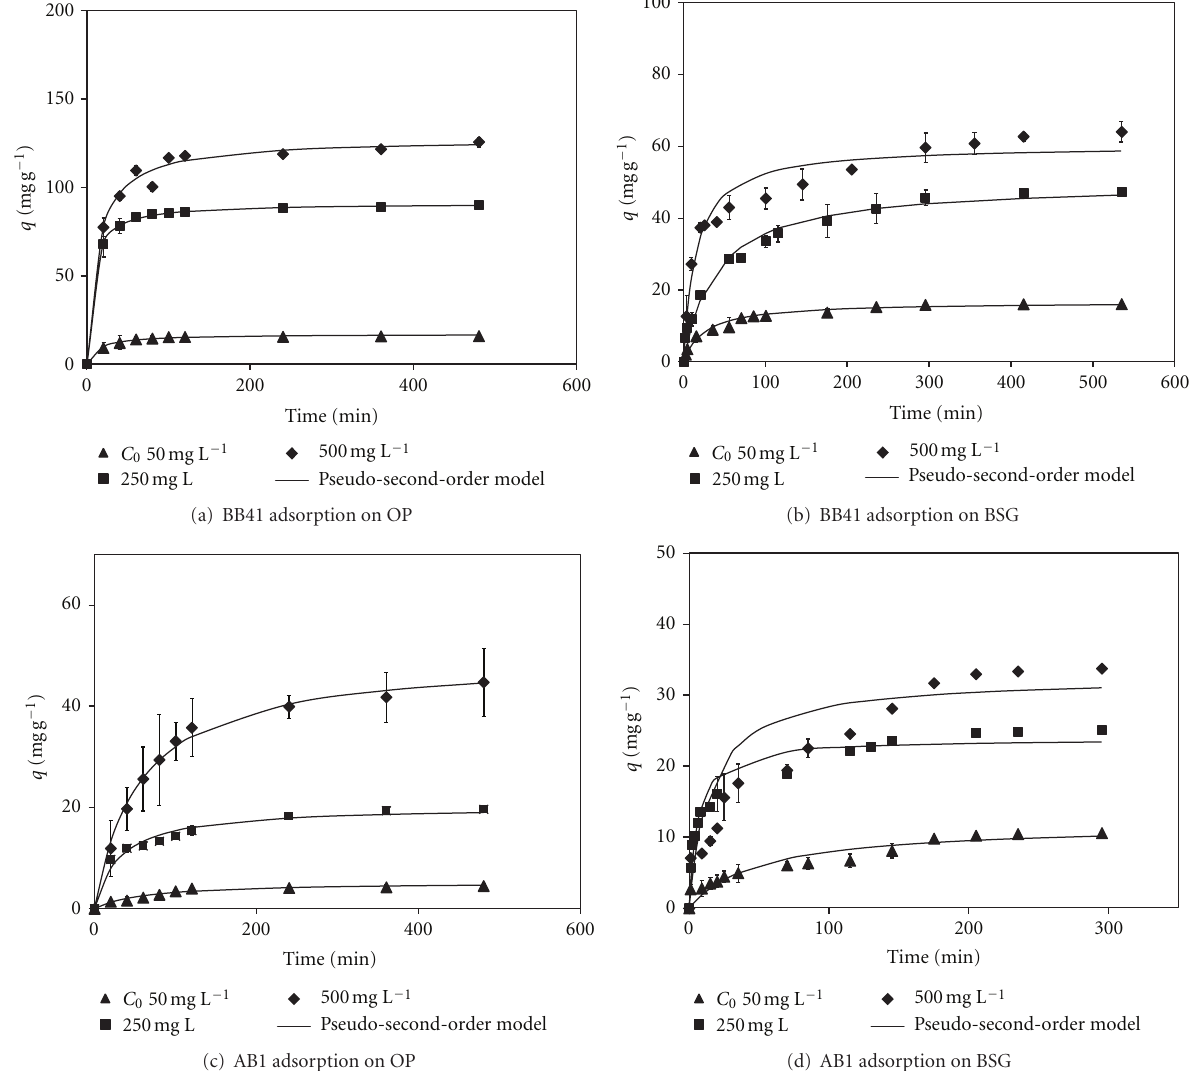
Figure 5: Kinetic modeling of dye adsorption on agroindustrial